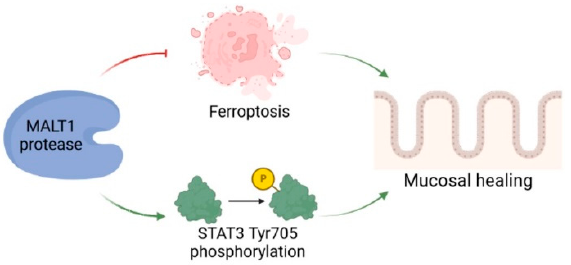
Figure 8. The role of MALT1 protease during mucosal wound healing. The proteolytic activity of MALT1 contributes to mucosal healing by blocking ferroptosis and promoting STAT3 activation in the intestinal epithelium. Created in Biorender.com.